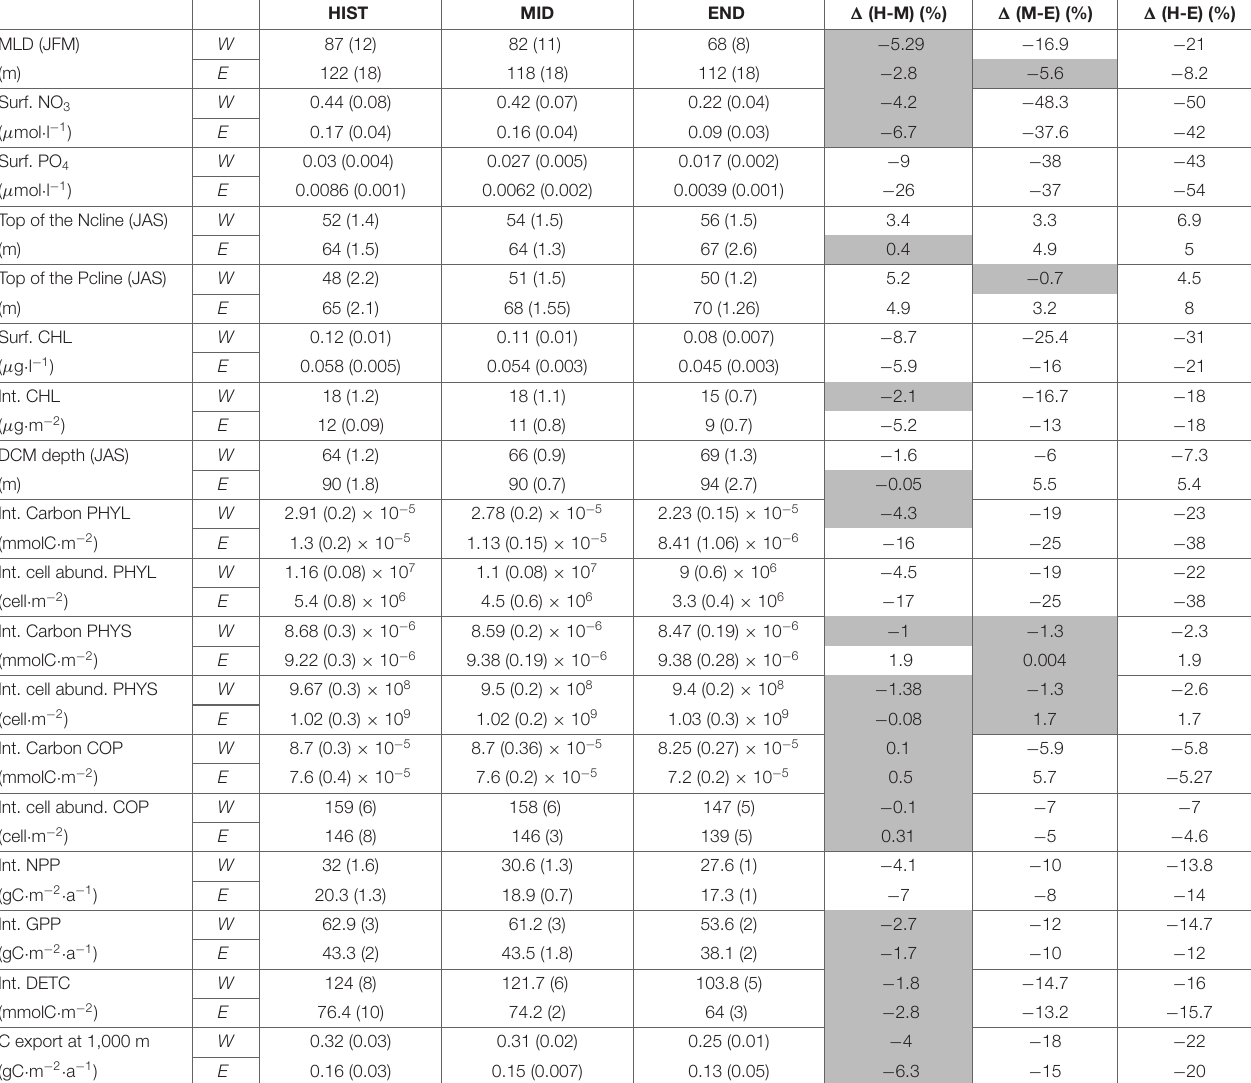
TABLE 1 | Summary of the main values of the simulation, HIST refers to the 1986–2005 period, MID to the 2031–2050 period and END to 2081–2100 period.